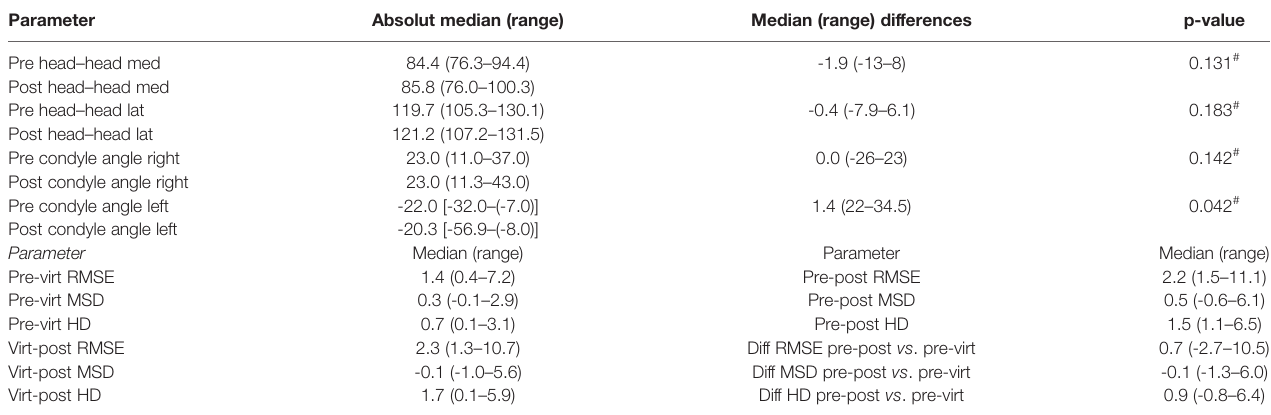
TABLE 2 | Results of conventional and three-dimensional